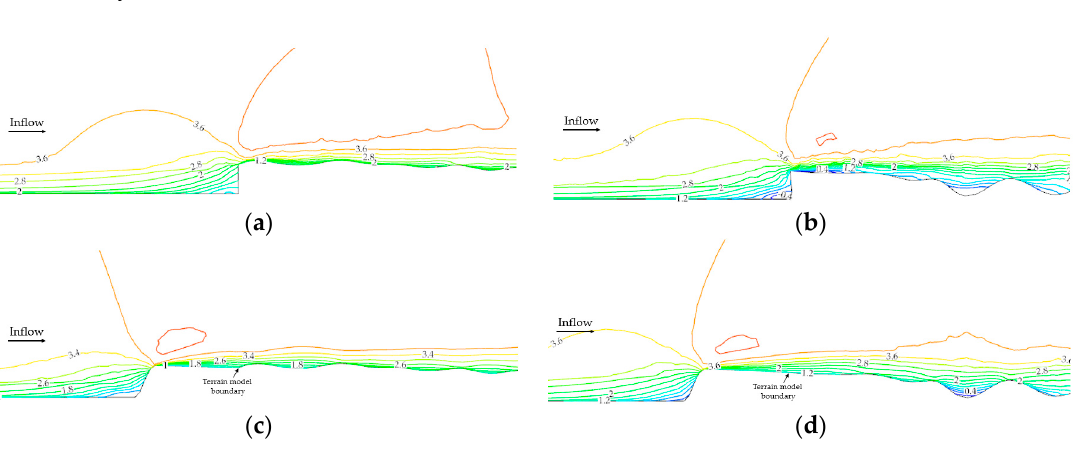
Figure 10. Wind speed distribution along the inflow direction near the inlet of the terrain model without or with improved BTS from CFD simulation (unit: m/s). ( a ) Case 1 without BTS; ( b ) Case 2 without BTS; ( c ) Case 1 with BTS; ( d ) Case 2 with BTS.